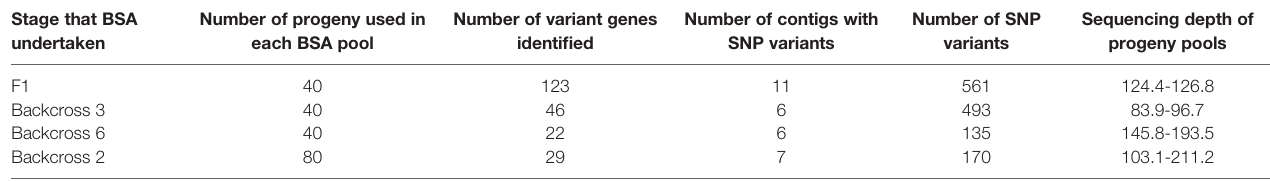
TABLE 1 | Summary of A. fumigatus bulk segregant analysis (BSA) for identi fi cation of the genetic basis of azole resistance in isolate